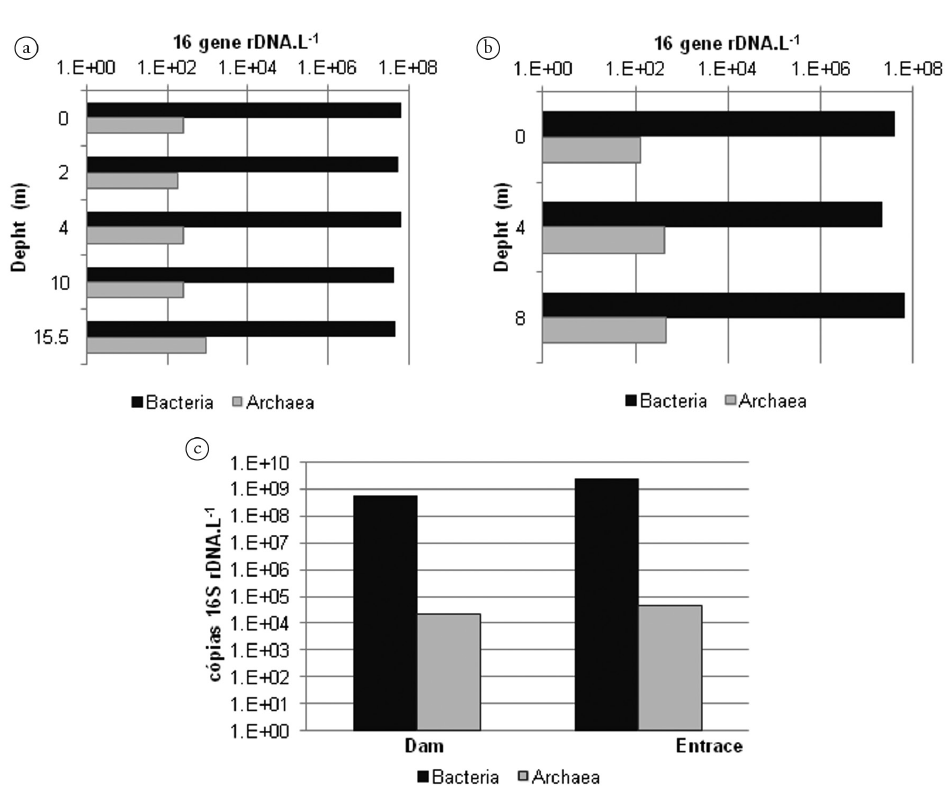
Figure 2. Relative abundance of Archaea and Bacteria community into the water column from (a) Dam, (b) Entrance and (c) Sediment of Itupararanga